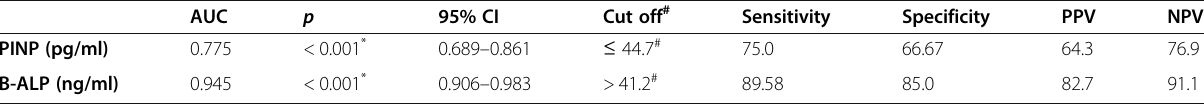
Table 4 Agreement (sensitivity, specificity) for PINP and B-ALP to discriminate osteopenia patients ( n = 48) from healthy control ( n = 60)